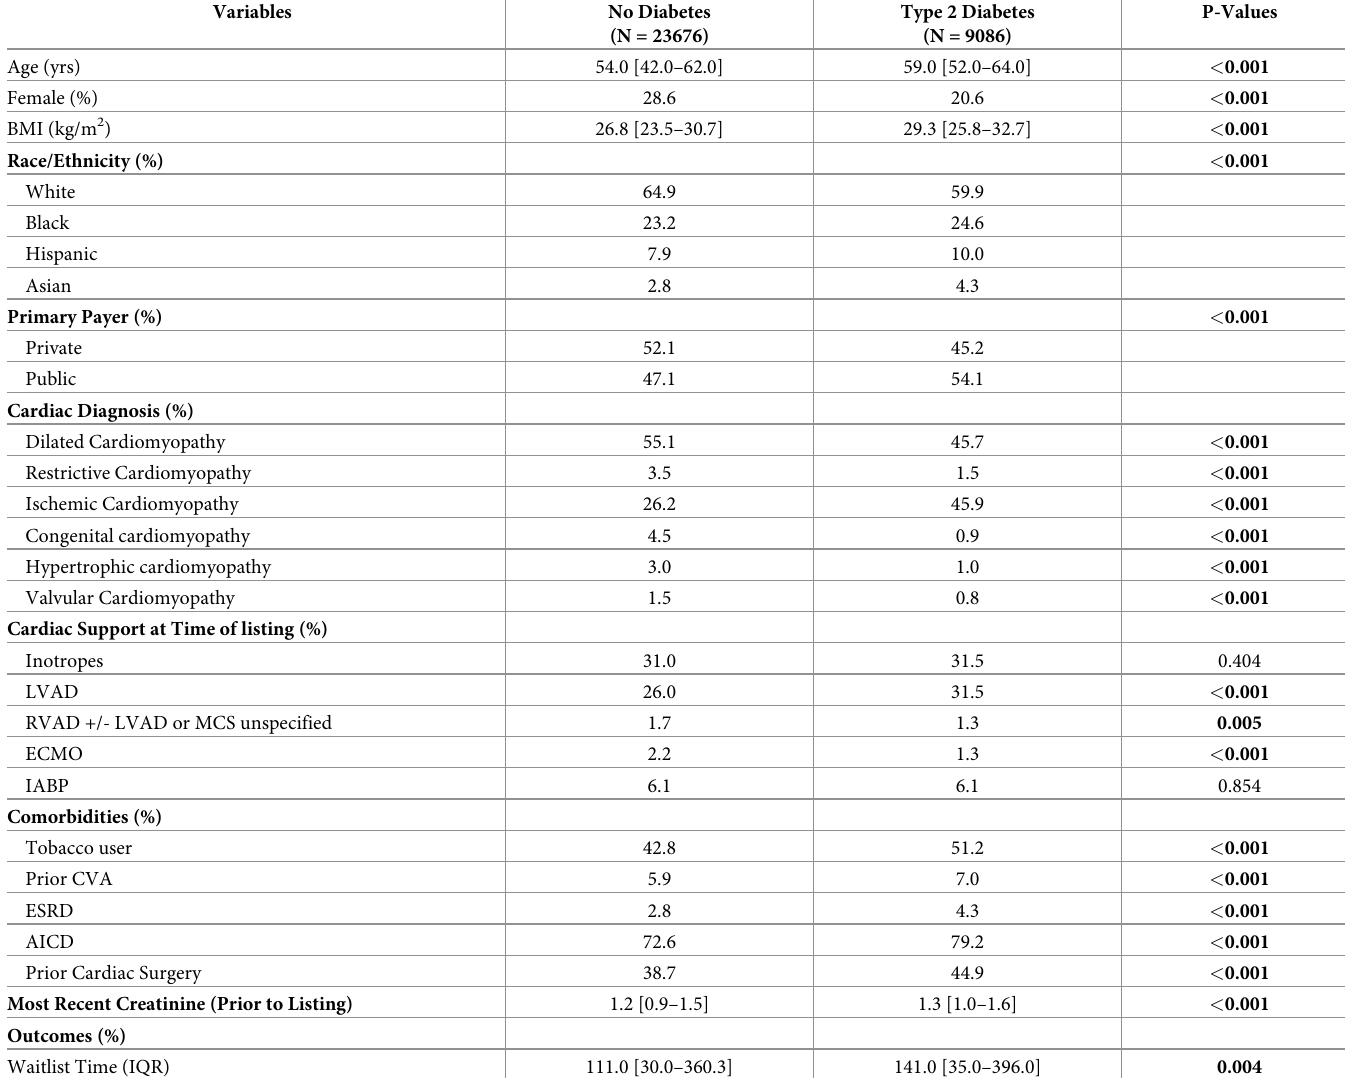
Table 1. Listing characteristics of patients according to Type 2 diabetes